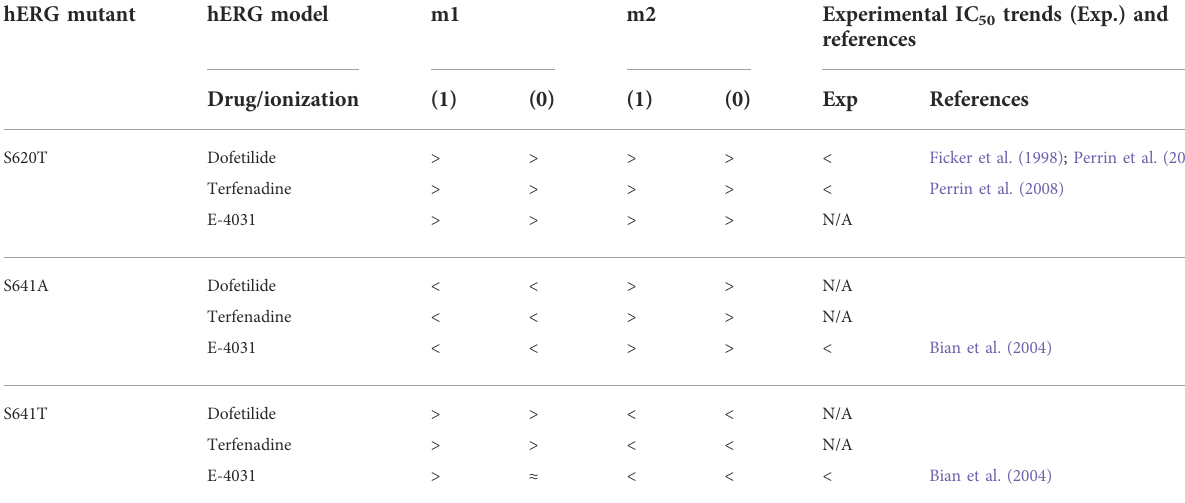
TABLE 2 Comparison between Rosetta GALigandDock interface scores and experimental IC 50 values for drug interaction with hERG mutants relative to the WT hERG channel. hERG mutant hERG model m1